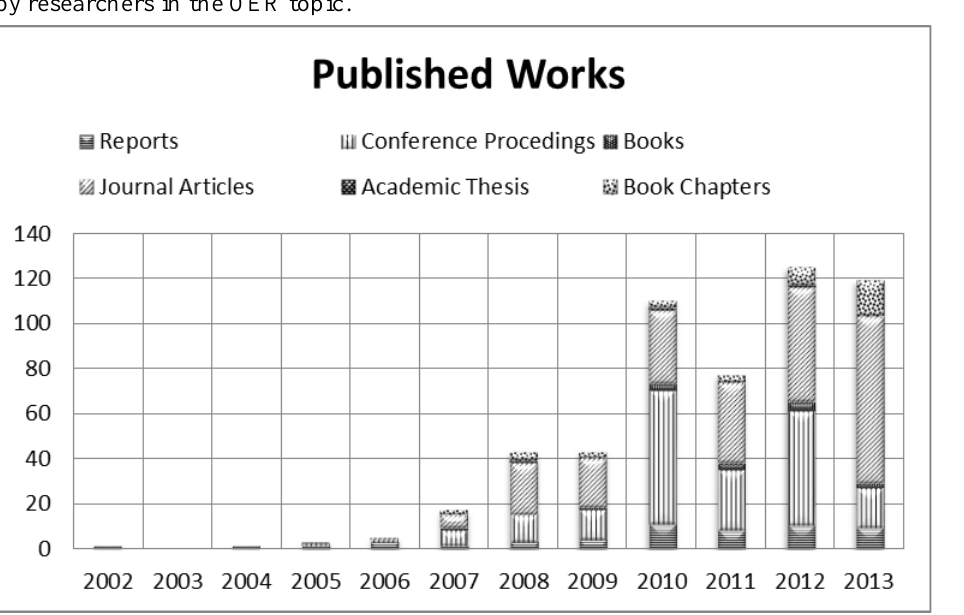
Figure 2. Graph of the number of works published per